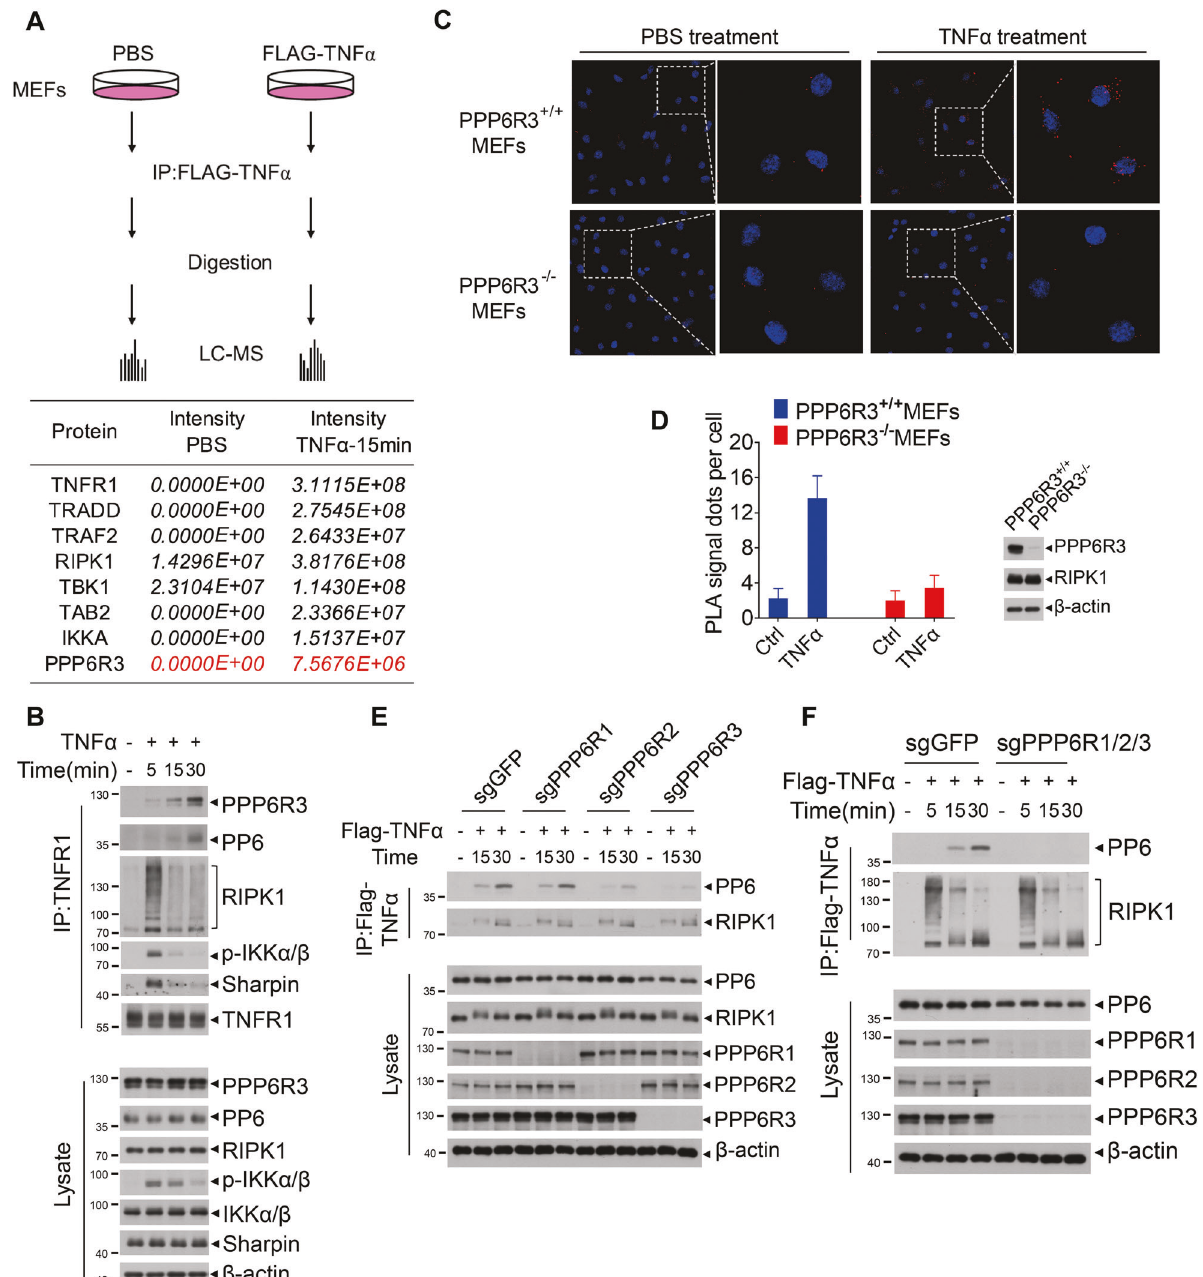
Fig. 1 PP6 is a previously unidenti fi ed component of complex I. A MEFs were treated with Flag-TNF α or PBS for 15 min. Cells were lysed with NP-40 buffer and immunoprecipitated with anti-Flag beads. The immunocomplexes were analyzed and quanti fi ed by mass spectrometry. The protein abundance represented as intensity was quanti fi ed by the summed peptide intensities of all extracted Ion chromatograms (XICs). Table below showed the proteins enriched in Flag-TNF α treatment group. B MEFs were treated with TNF α for indicated periods of time. Cells were lysed with NP-40 buffer and immunoprecipitated with anti-TNFR1 antibody. The immunocomplexes and whole-cell lysates were analyzed by western blotting with indicated antibodies. C PPP6R3 + / + or PPP6R3 − / − MEFs were treated with PBS or TNF α for 30 min. In situ PLA assay was performed to detect the interaction between RIPK1 and PPP6R3. Red dots indicated the interaction signal of RIPK1 and PPP6R3. D Quanti fi cation analysis of the PLA signal dots of RIPK1 and PPP6R3. 20 cells were counted for each group. The panel on the right showed the knockout ef fi ciency of PPP6R3. E PPP6R1, PPP6R2, or PPP6R3 knockout MEFs were treated with Flag-TNF α for indicated periods of time. Cells were lysed with NP-40 buffer and immunoprecipitated with anti-Flag beads. The immunocomplexes and whole-cell lysates were analyzed by western blotting with indicated antibodies. F WT or PPP6R1/2/3 triple-knockout MEFs were treated with Flag-TNF α for indicated periods of time. Cells were lysed with NP-40 buffer and immunoprecipitated with anti-Flag beads. The immunocomplexes and whole-cell lysates were analyzed by western blotting with indicated antibodies. Concentrations of reagents used: Flag-TNF α , 150 ng/ml; TNF α , 50 ng/ml.